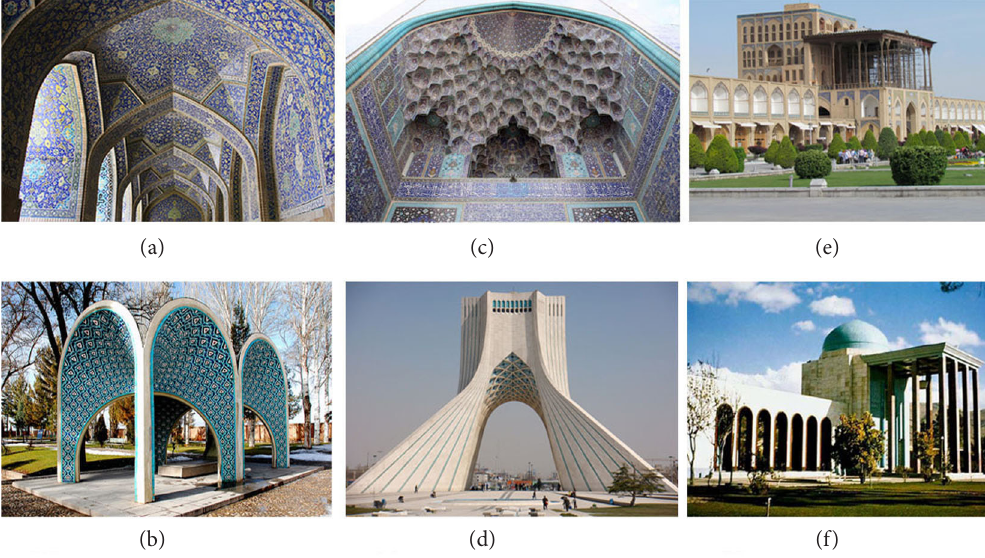
Figure 2. Examples of patterns of historical Iranian architecture as sources of inspiration for Iranian architects between the years 1940−1970: (a) Imam Mosque from 1611 in Isfahan (Veisi, 2008); (b) Kamal-ol-Molk Tomb by Houshang Seihoun in Khorasan, 1963 (Mansour, 2003); (c) Moqarnas; (d) Azadi Square in Tehran by Hossein Amanat, 1970; (e) Ali Qapou from Safavid era (Author, 2011); (f) Saadi Tomb by Mohsen Foroughi,